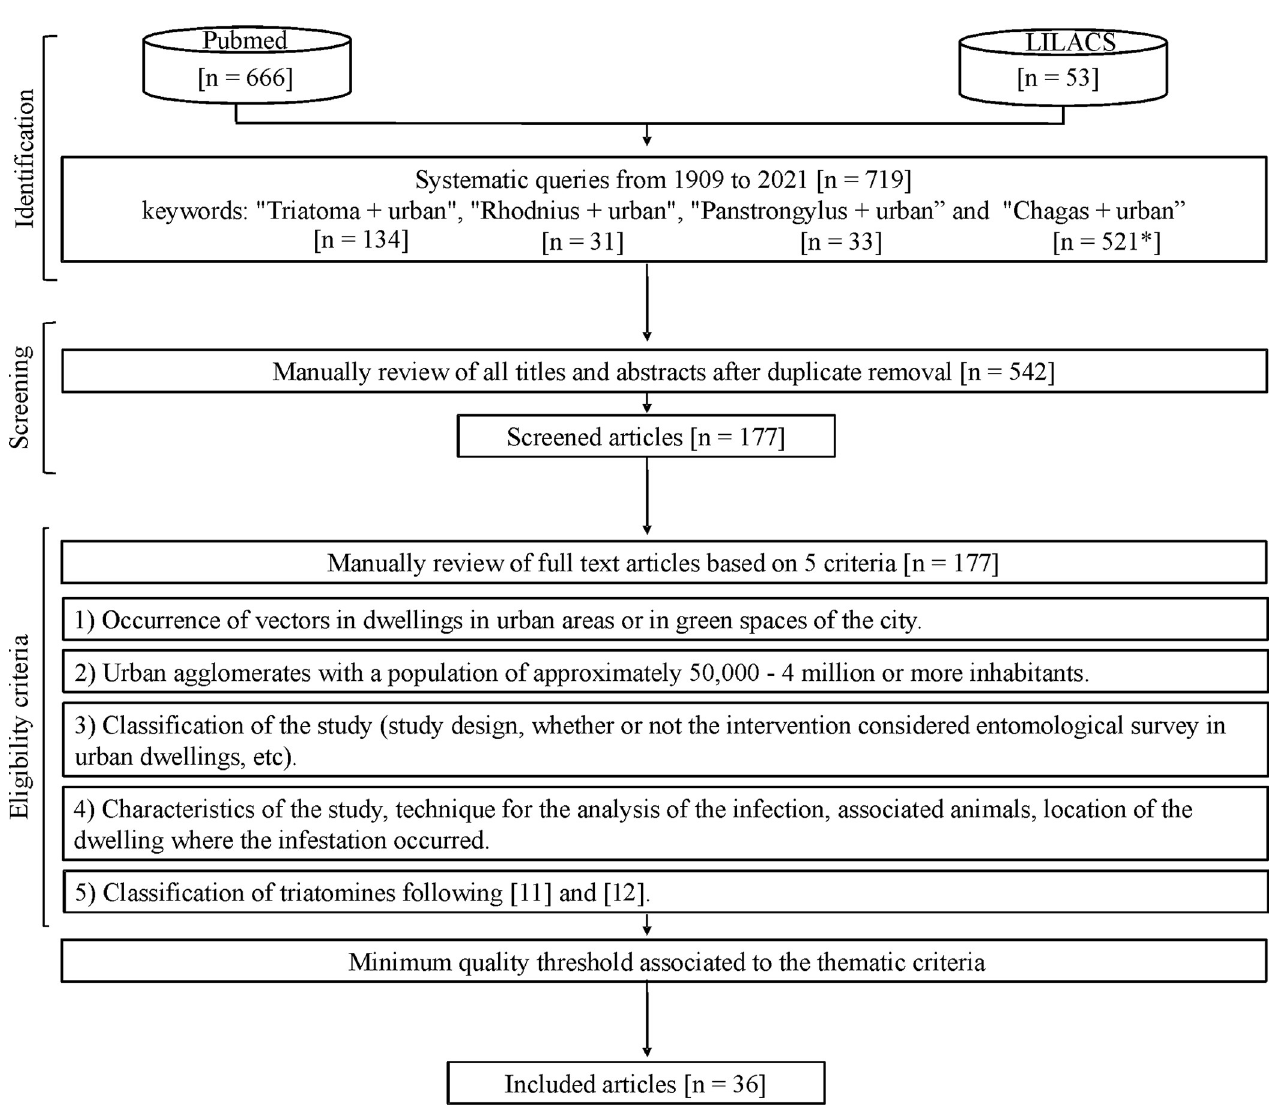
Fig 1. Flow diagram of the systematic review process. Scientific production available in the search engines PubMed (P) and LILACS (Latin American and Caribbean Literature in Health Sciences; L). � Registered value for Pubmed search.